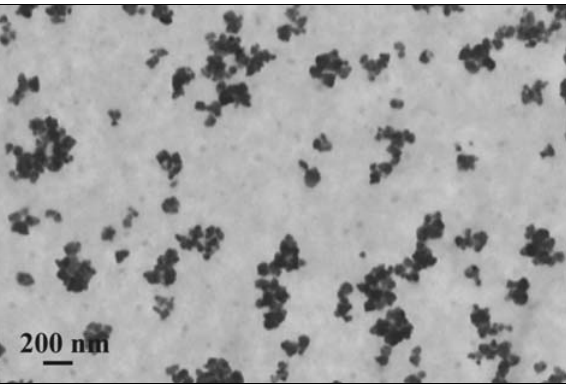
higher values but remains inside the range from ∼ 240 °C to ∼ 400 °C. However, the profiles of the TG curve and, con- sequently, the DTG and DTA curves change. In the latter case, inside the decomposition interval of ZnO-PMMA, the DTG curve predicts one additional distinctive step.